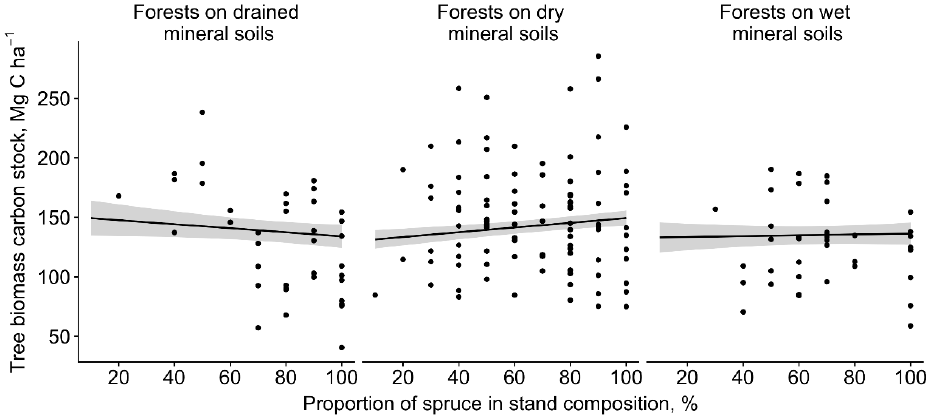
Figure 2. Influence of proportion of spruce in the stand composition on tree biomass (above- and belowground biomass) carbon stock (±95% confidence interval (grey area)) in different forest site types.